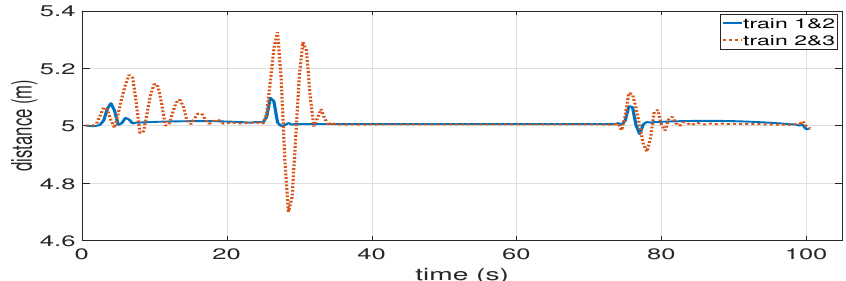
Figure 11. The distance of trains in VC driving on inter-station with AMPCVS system.